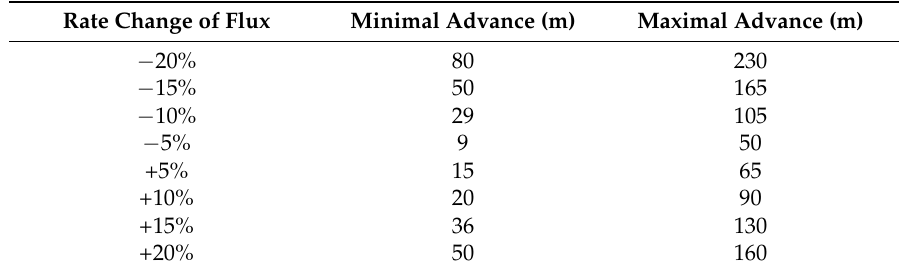
Figure 5. Position of the 100 m level set of the seawater/freshwater interface for different values of flux: ( a ) 20% reduction, ( b ) 15% reduction, ( c ) 10% reduction, ( d ) 5% reduction, ( e ) 5% increase, ( f ) 10% increase, ( g ) 15% increase, and ( h ) 20% increase. Table 2. Advancement inland of the seawater/freshwater interface (m) with respect to the rate change of flux.